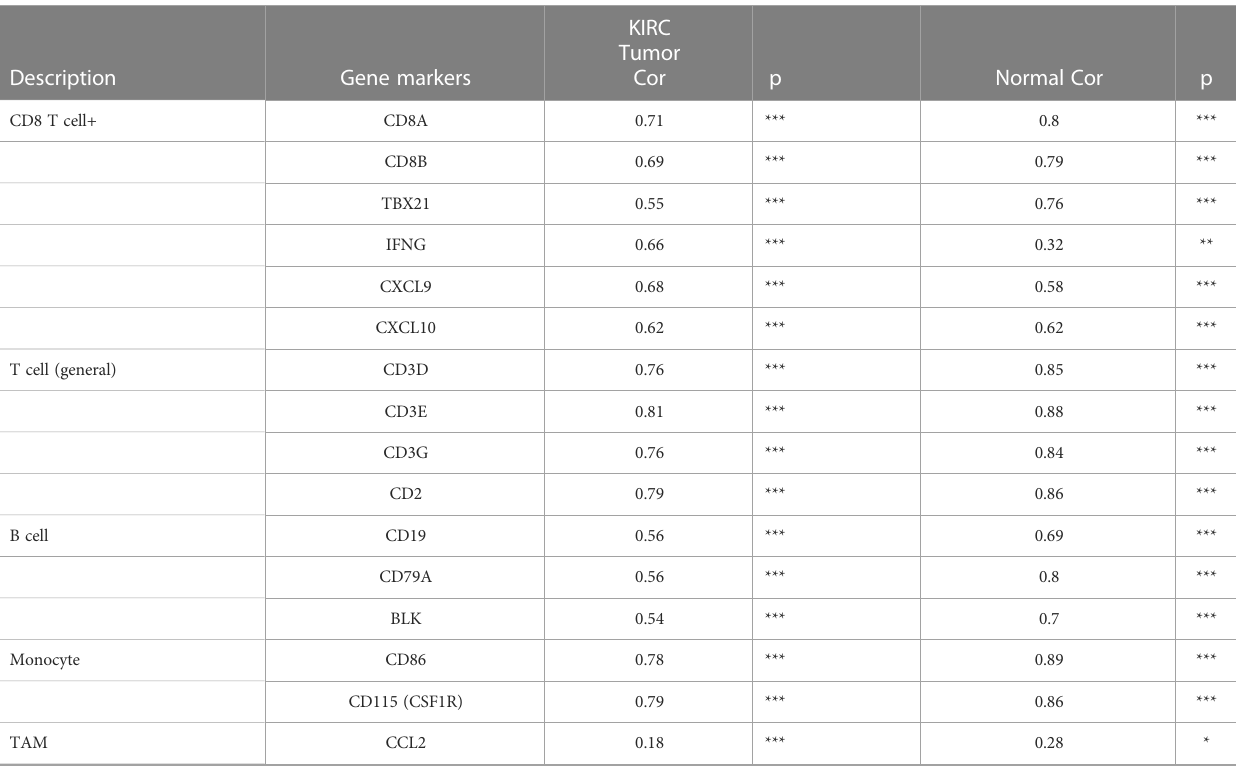
TABLE 3 Correlation analysis between WAS and related genes and markers of monocyte, macrophages, and T-cell exhaustion in Gene Expression Pro fi ling Interaction Analysis (GEPIA). Description Gene markers